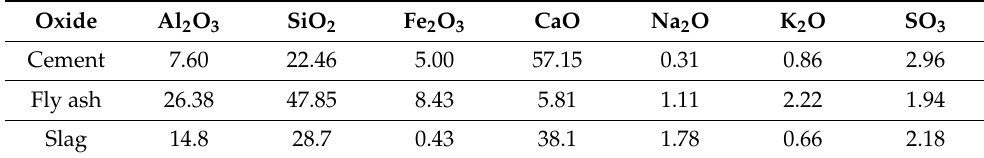
Table 1. Chemical properties of the cement, fly ash, and slag